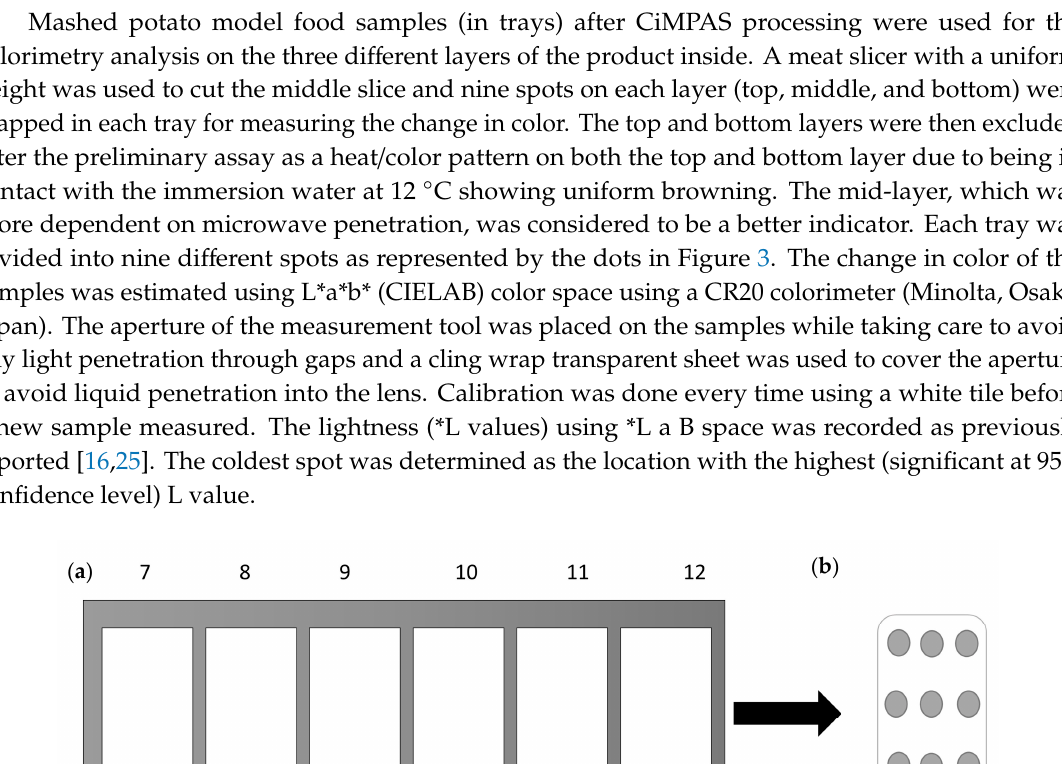
Figure 2. Return on investment (ROI) extraction processes for mashed-potato hyperspectral imaging (HSI) images.